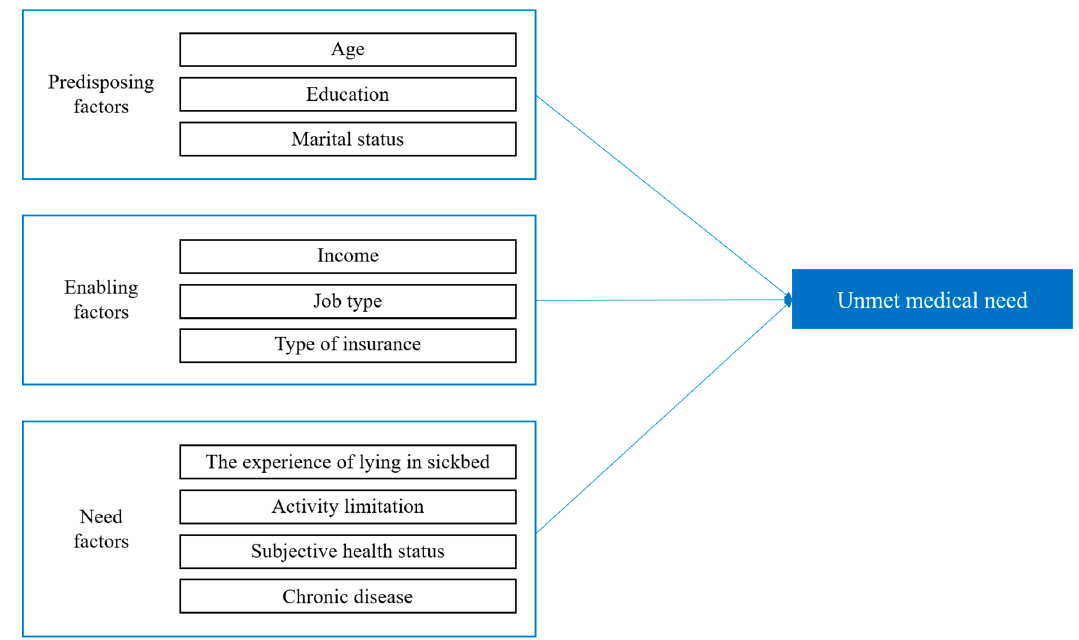
Figure 1. Research